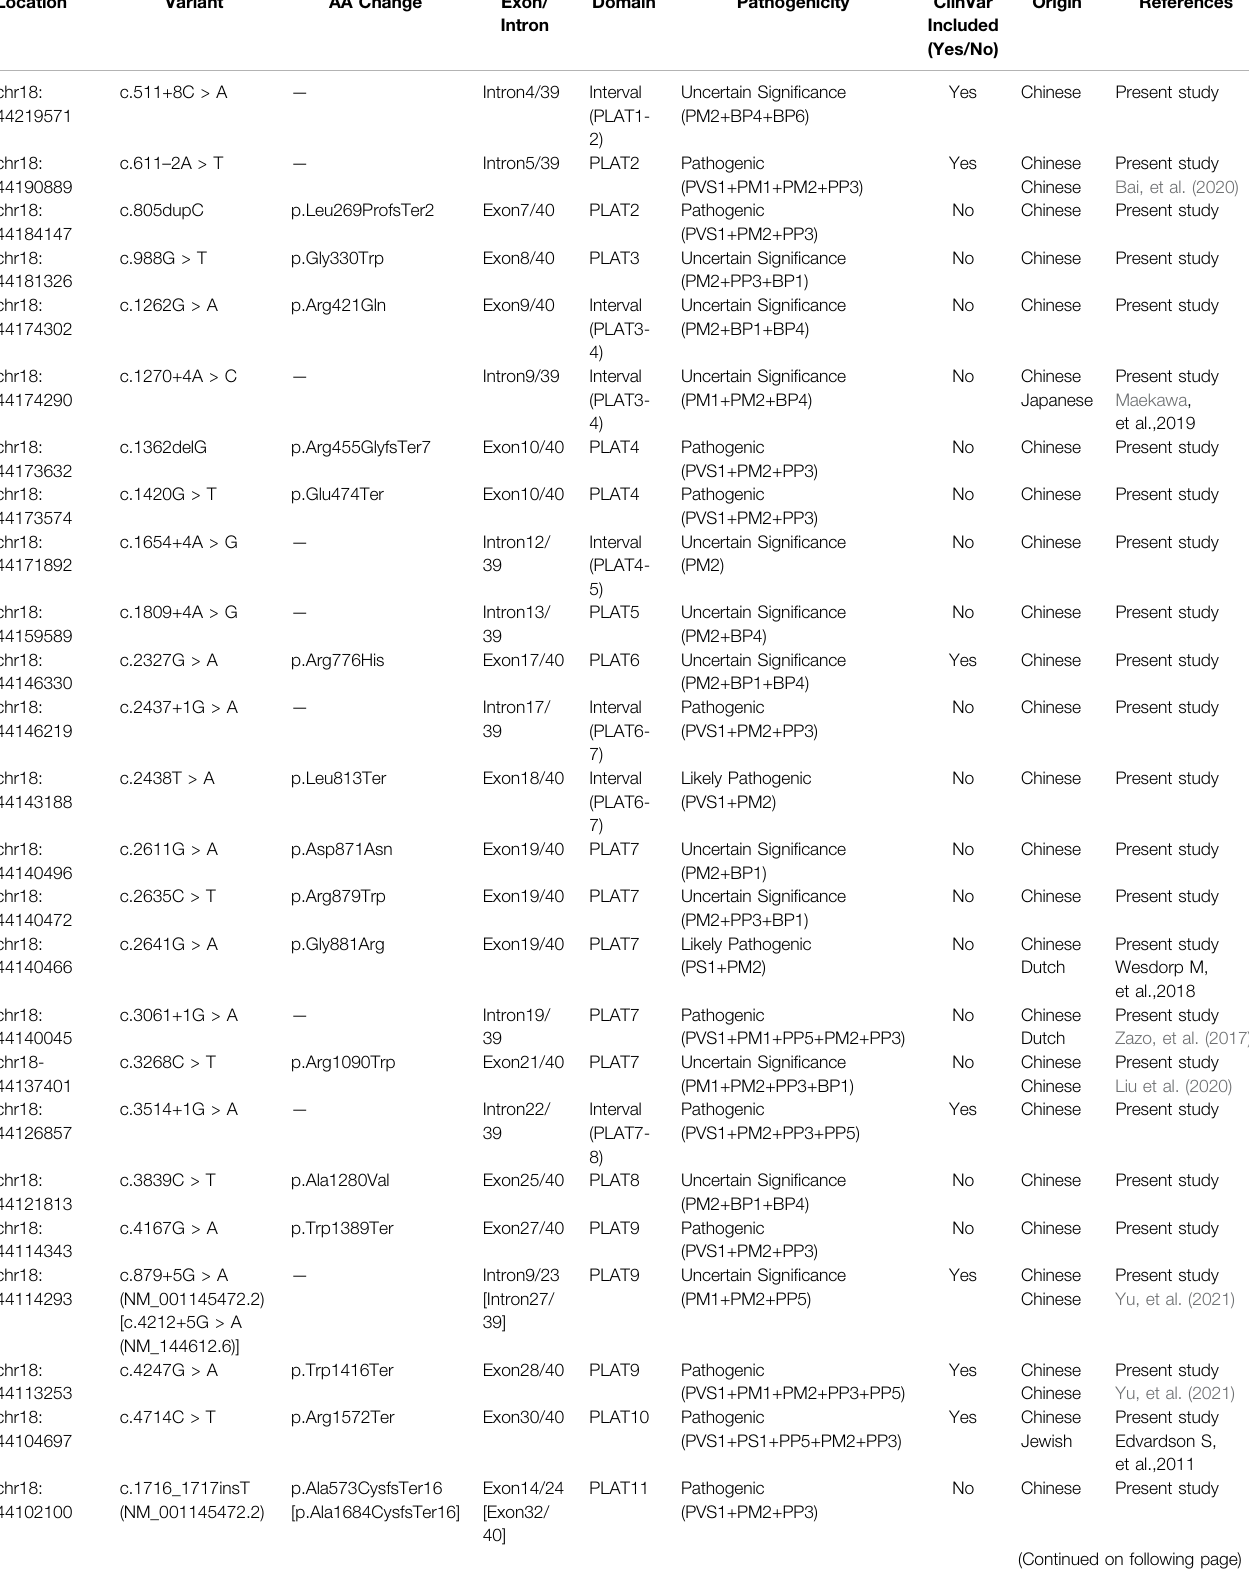
TABLE 1 | All possibly causative variants of LOXHD1 identi fi ed in this study